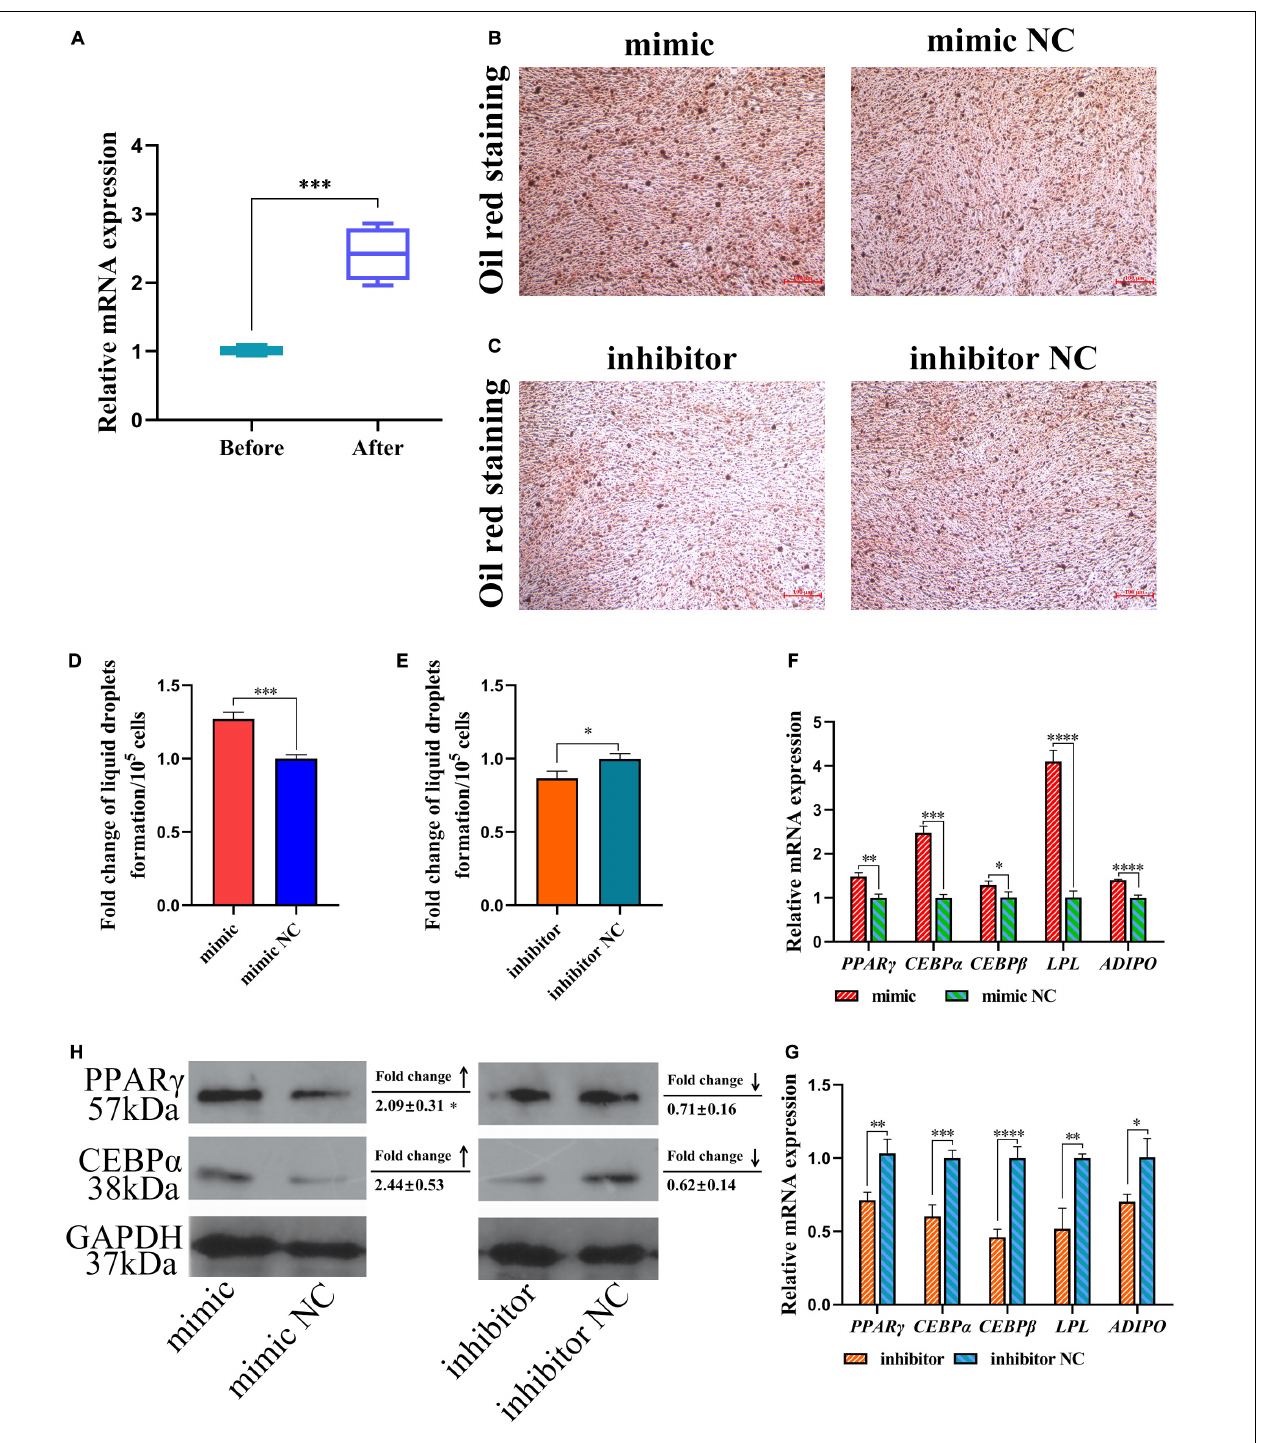
FIGURE 5 | miR-429-3p promotes preadipocytes differentiation via PPAR γ pathway. (A) Relative expression of miR-429-3p before and after preadipocytes differentiation. (B,C) Oil red staining for lipid droplet formation. (D,E) The fold change of lipid droplets formation per 10 5 cells. (F,G) Relative mRNA expression of PPAR γ , C/EBP α , C/EBP β , LP L, and ADIPO in in ICP-1 cells. (H) The western blot for PPAR γ and C/EBP α proteins in ICP-1 cells. Data presented as mean ± SEM, * P < 0.05; ** P < 0.01; *** P < 0.001; **** P < 0.0001; ns: no significance.